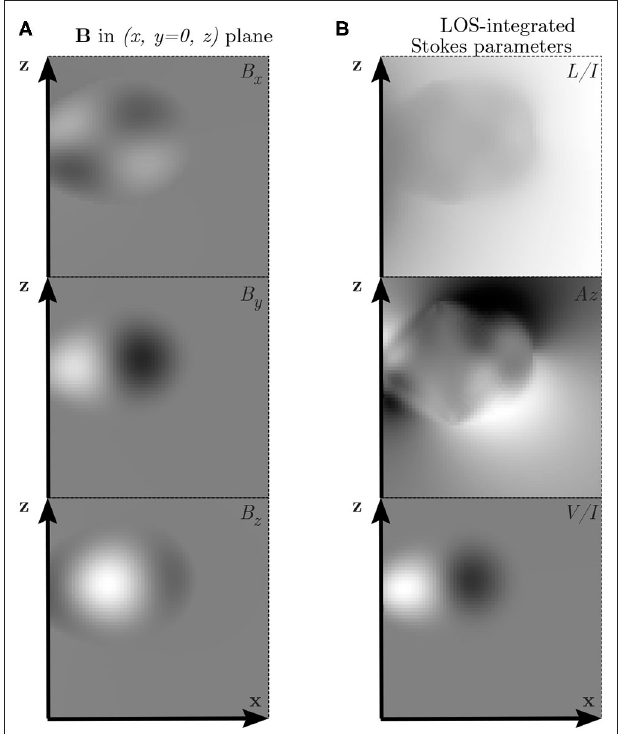
FIGURE 6 | Left : an example of input for Experiment 1, three components of the magnetic field evaluated in the y = 0 plane, which is equivalent to an observation in quadrature to Earth. (This is akin to a vector magnetogram observed in the quadrature in the ( x , y = 0, z ) plane.) Right : an example of input for Experiment 2, three synthetic spectropolarimetric images, as they would appear to the same observer. These data are for f = 2.1 R ⊙ , (cid:127) = 35 ◦ , σ = 180 ◦ , τ 1 = 3.38, θ = 7 ◦ . The field of view (FOV) is the same in all panels: x ∈ [1.0,2.6] R ⊙ , z ∈ [ − 0.8,0.8] R ⊙